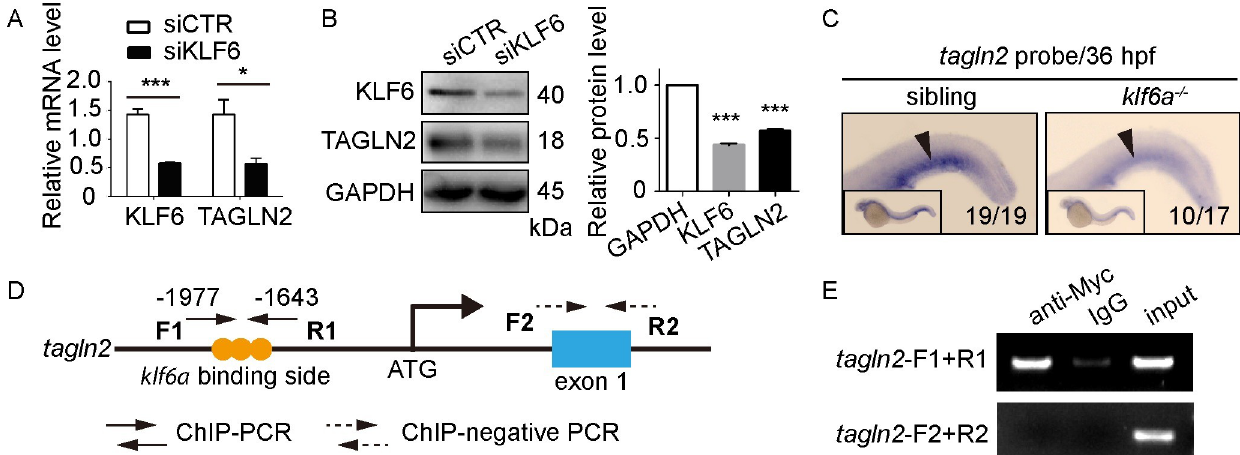
Fig 6. Tagln2 is a direct downstream target of klf6a . (A) and (B) SiKLF6 in HUVECs efficiently decrease TAGLN2 expression at the mRNA (KLF6: P = 0.0009, TAGLN2: P = 0.0352) and protein (KLF6: P < 0.0001, TAGLN2: P < 0.0001) levels. Student’s unpaired two-tailed t test. � P < 0.05, ��� P < 0.001. (C) WISH of the tagln2 gene of sibling and klf6a -/- zebrafish at 36 hpf. Arrowheads indicate the CVP region expressing tagln2 . (D) Structure of the tagln2 promoter. The primer tagln2 -F1+R1 contains the conserved Klf6a binding side-CACCC, whereas tagln2 -F2+R2 is a negative control located in the tagln2 exon 1. (E) ChIP-PCR of the tagln2 promoter shows that Klf6a can bind directly to the tagln2 promoter.